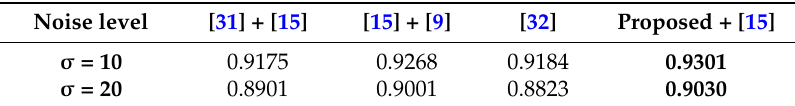
Average SSIM comparisons for the denoised and color interpolated results of Calendar